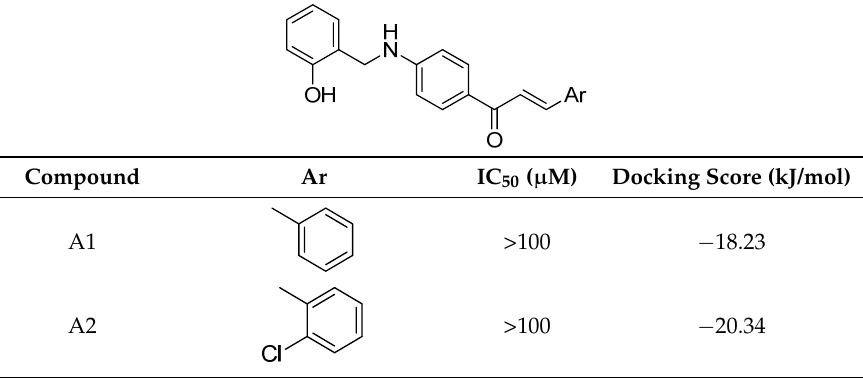
Table 2. Inhibition of AChE (acetylcholinesterase) activity and docking